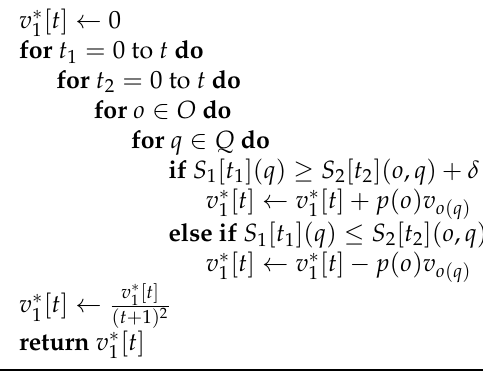
[ t ] in continuous 1